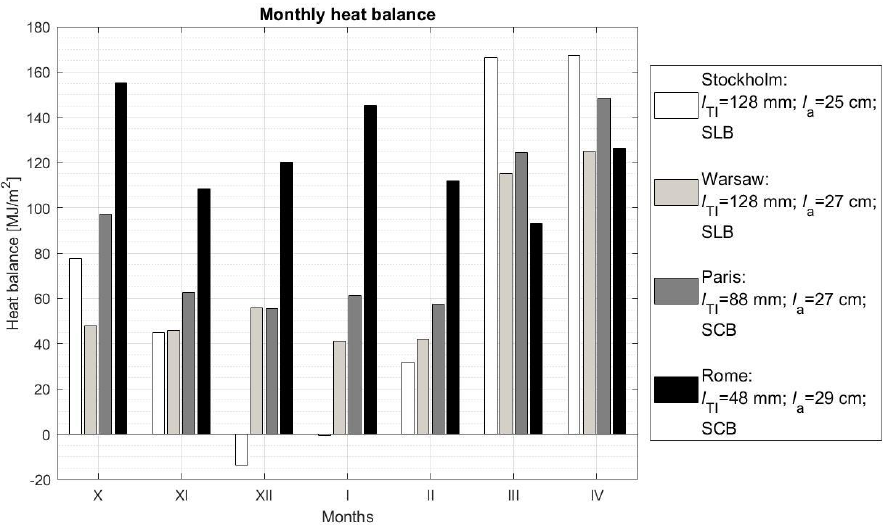
Figure 12. Comparison of monthly heat balances for the SWs with the TI thickness and AL parameters and materials proposed for the considered locations.